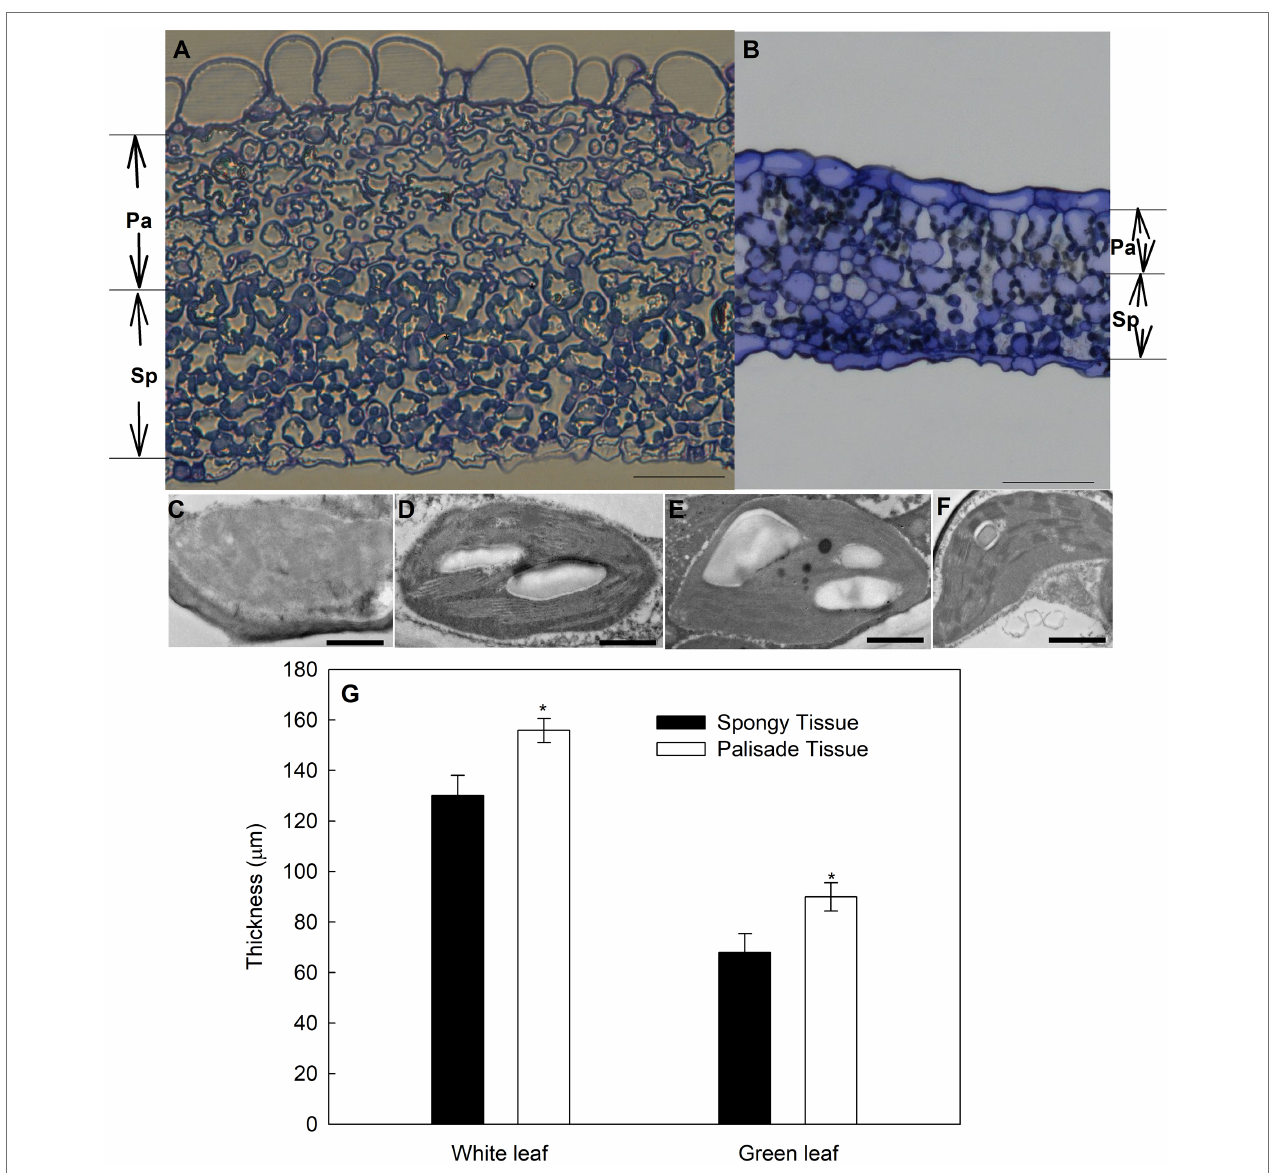
FIGURE 4 | Anatomical features of green and variegated leaves of variegated A. kolomikta in late-May when variegated leaves were white. (A) Transverse sections from variegated leaves. (B) Transverse sections from green leaves. Chloroplast of palisade tissue (C,E) and spongy tissue (D,F) in white and Green leaves. ( G ) Mean thickness of different tissues in green and white leaves of A. kolomikta. Pa, palisade tissue; Sp, spongy tissue. Scale bars: (A,B) = 50 μ m, (C–F) = 500